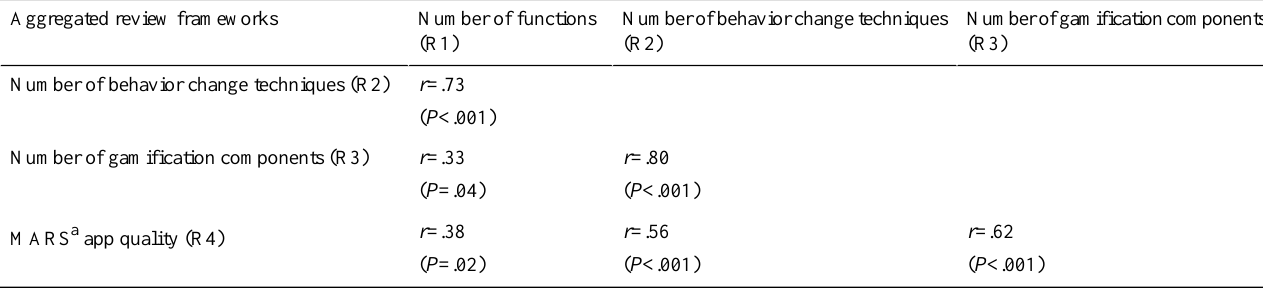
Table 4. Pearson correlations between aggregated review frameworks (N=38). All ratings of behavior change techniques and gamification components were included in the analysis (including techniques and components rated as “partially applied or